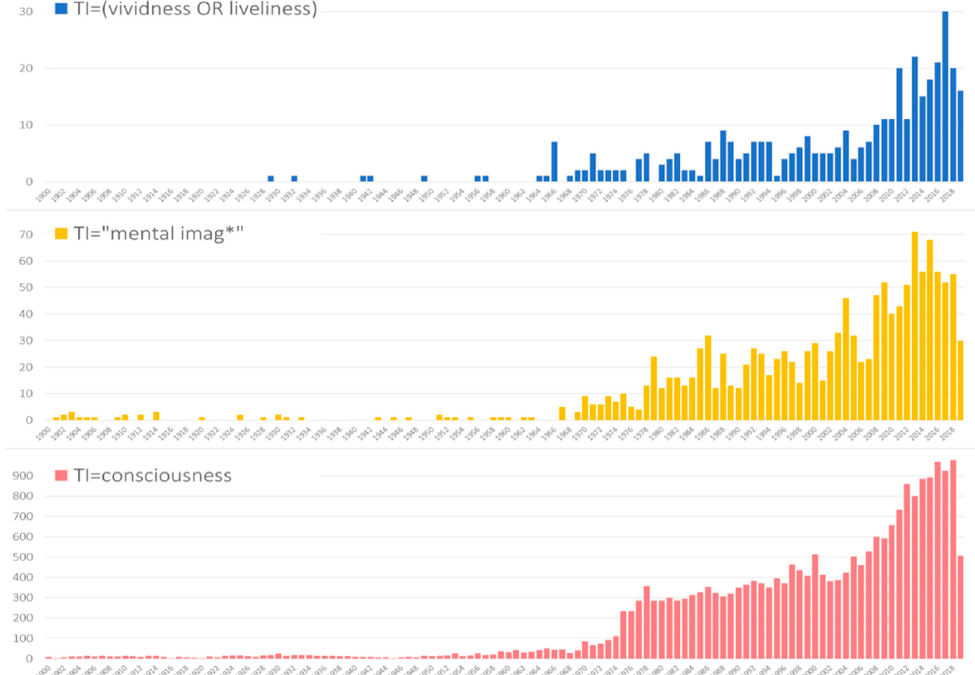
Figure 1. Annual publication rates in Web of Science (WoS) for documents with search terms in the title.